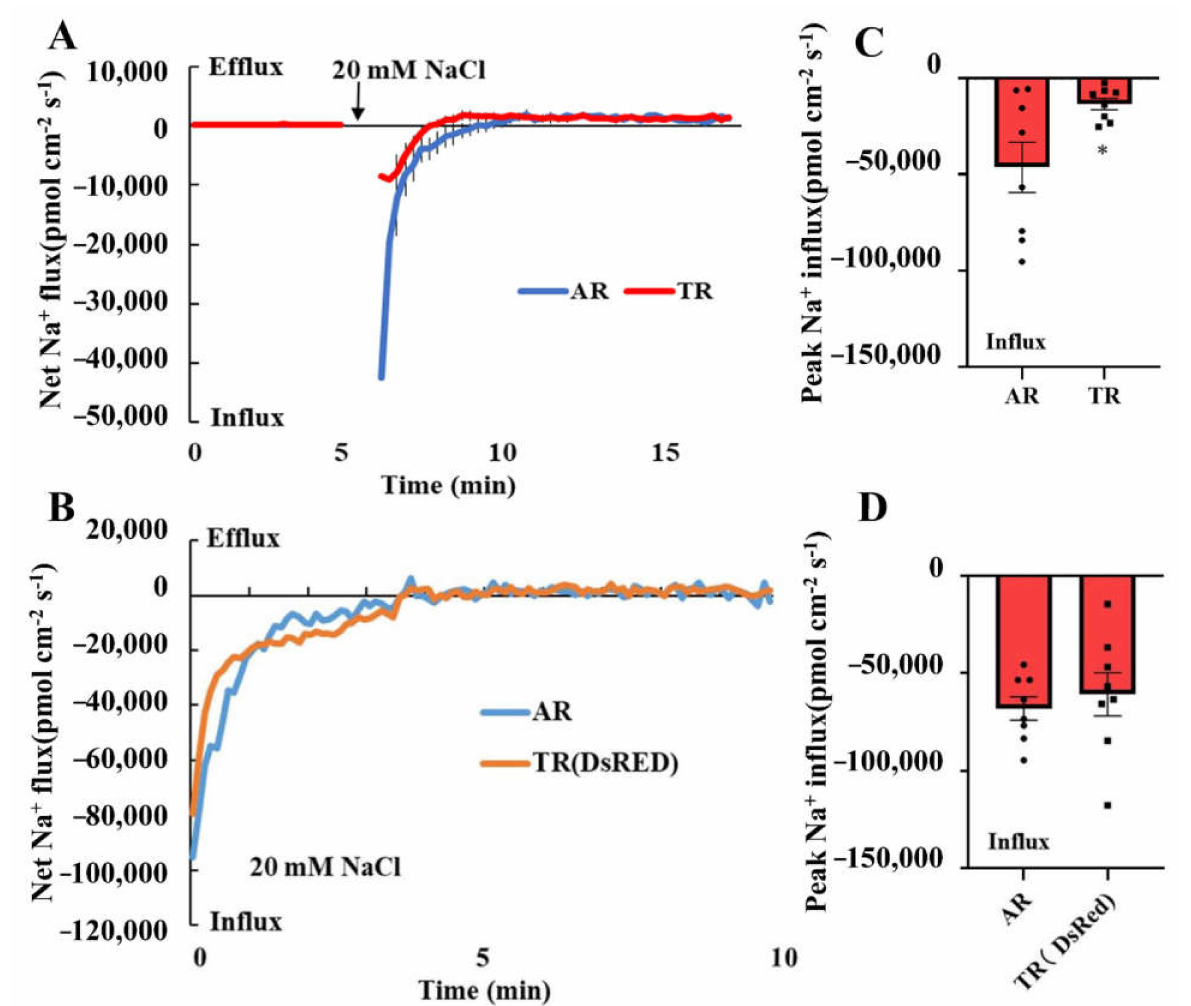
Figure 4. Overexpression of IbIPUT1 inhibits Na + uptake in sweet potato roots. ( A ) Transient Na + influx upon treatment with 20 mM NaCl was measured from the elongation root zone (2 mm from the tip) of adventitious roots (ARs) and IbIPUT1 -transgenic roots (TRs) through NMT. n = 8 from four seedlings. ( B ) Peak Na + influx rate in ( A ). Columns labeled with “*” indicate significant difference between ARs and TRs at p < 0.05. ( C ) Transient Na + flux upon 20 mM NaCl was measured via NMT from the elongation root zone (2 mm from the tip) of ARs and DsRed -transgenic roots ( n = 7). ( D ) Peak Na + influx rate in ( C